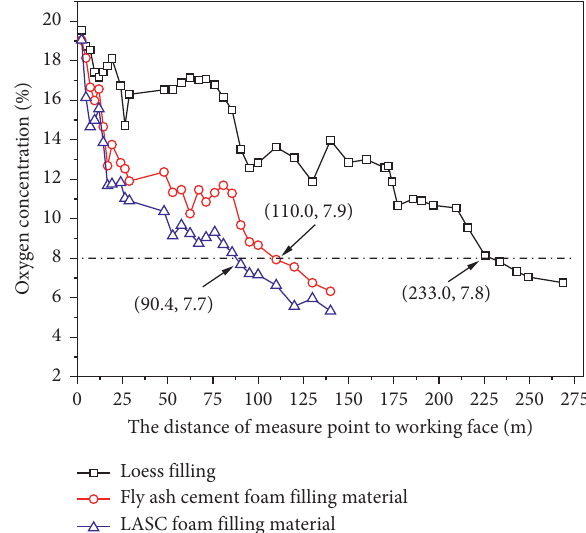
Figure 17: Concentrations of oxygen in a gob